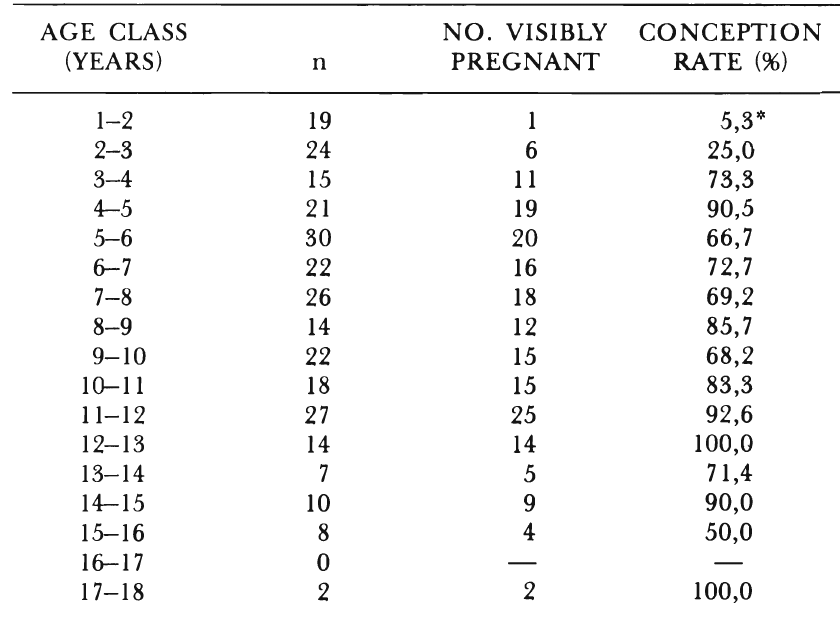
Age-specific conception rates for 279 Burchell's zebra mares collected in the Central District ojthe Kruger National Park between 1969 and